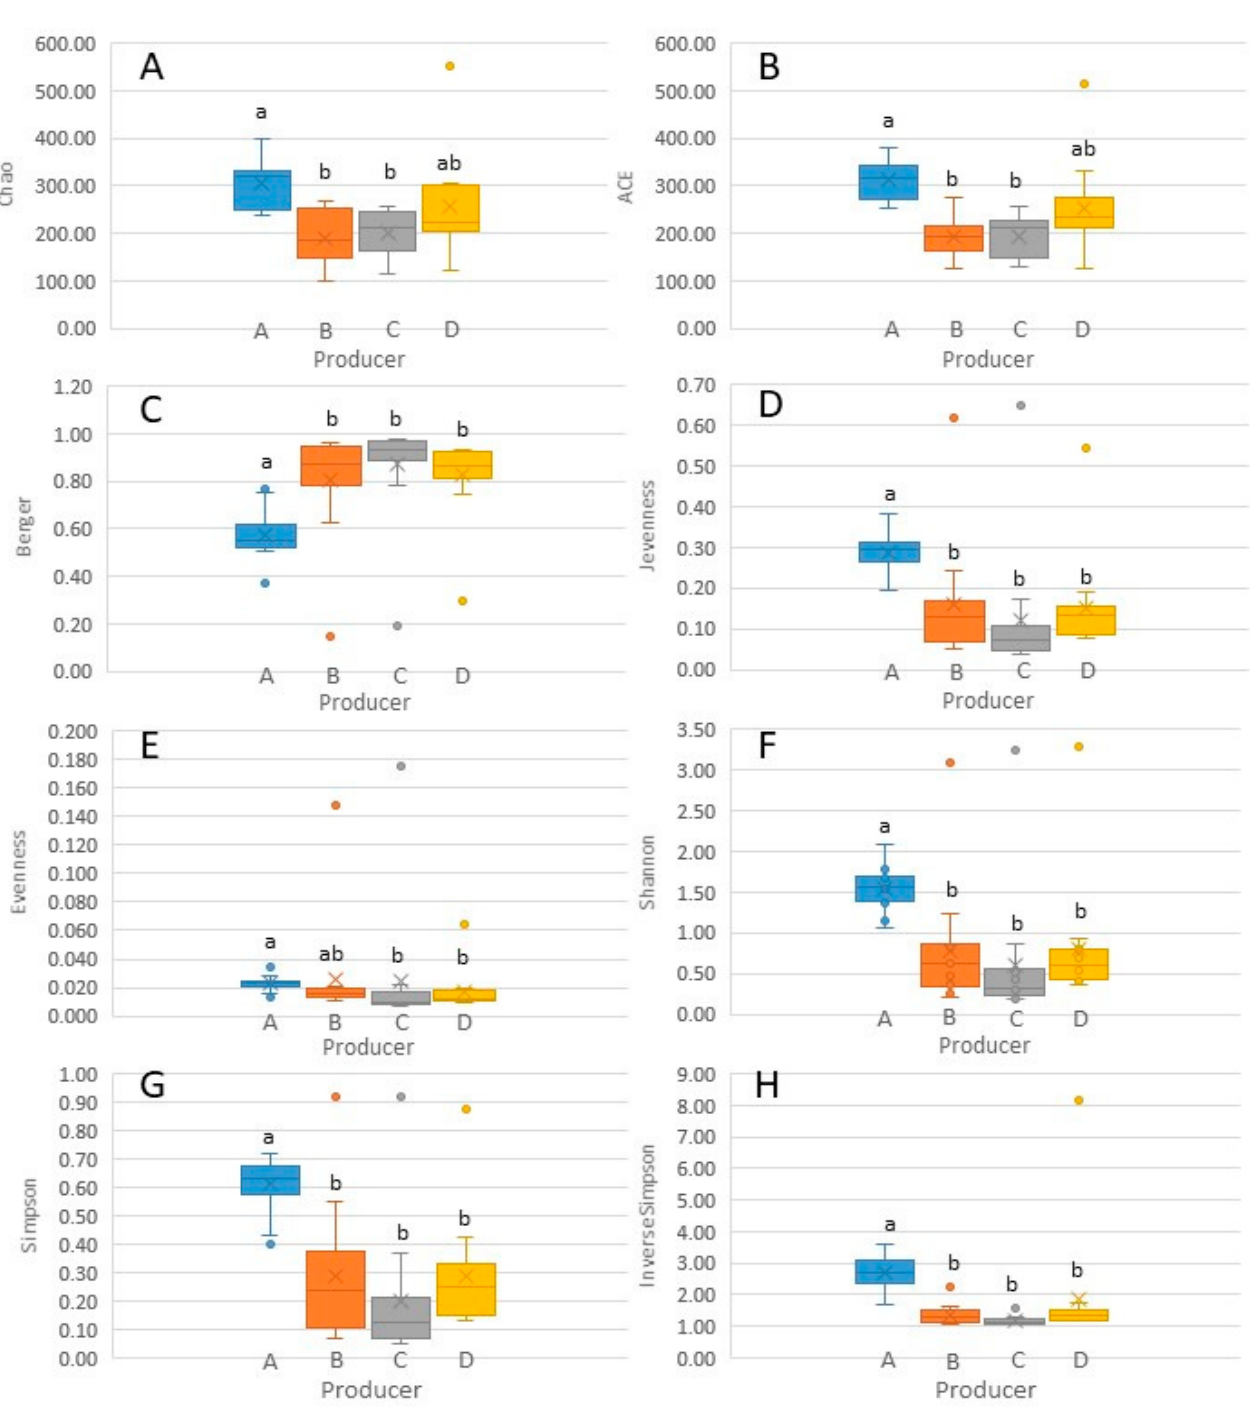
Figure 5. Box plot representation of bacterial alpha diversity indices (( A ) Chao1; ( B ) ACE; ( C ) Berger; ( D ) Jevenness; ( E ) Eevenness; ( F ) Shannon; ( G ) Simpson; ( H ) Inverse Simpson) of Latxa ewe raw milk and Idiazabal cheese samples obtained from four producers (A, B, C and D). For each diversity index, different letters indicate significant differences between producers at p ≤ 0.05.